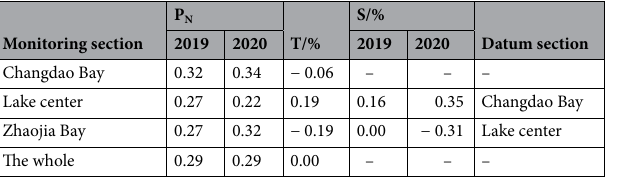
Table 7. Temporal and spatial changes of water quality in each monitoring section of Lugu Lake from 2019 to 2020.